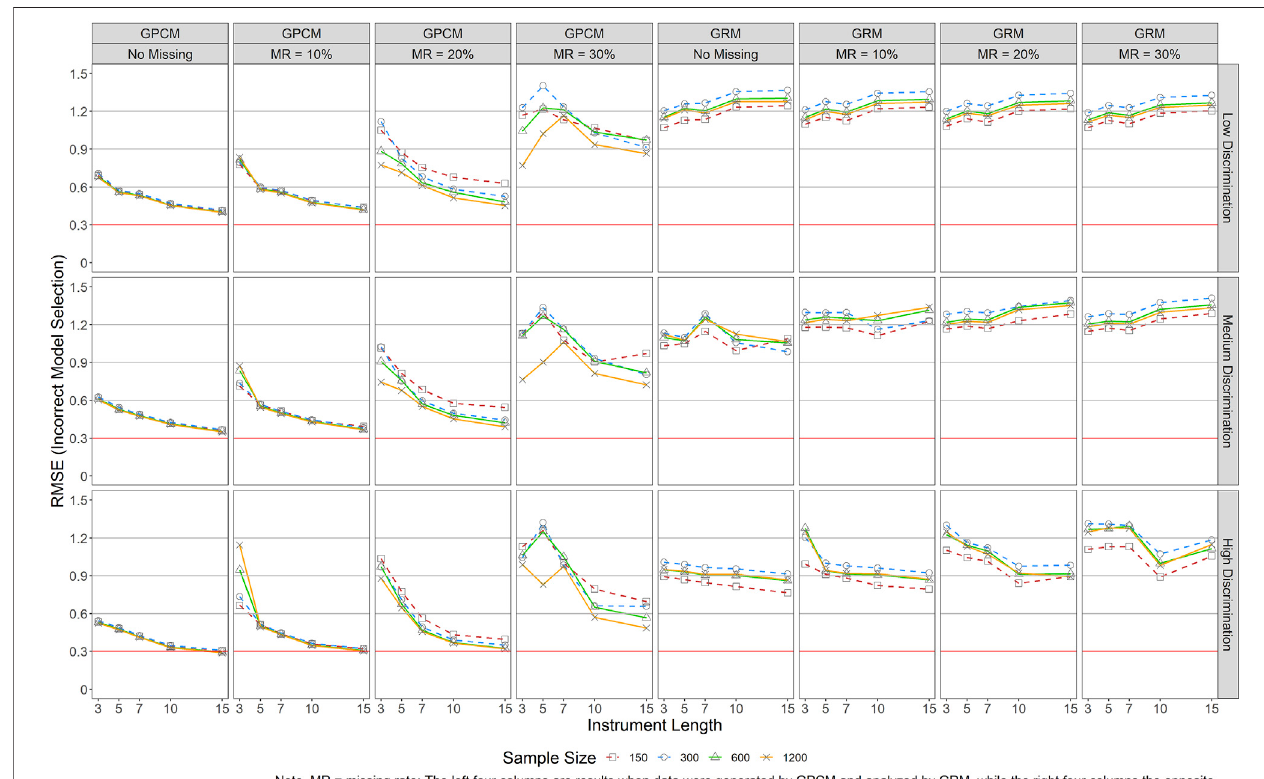
FIGURE 9 | RMSE Results of Person Parameter Estimations for Both GRM and GPCM (Incorrect Model Selection). Note. MR (cid:1) missing rate; The left four columns are results when date were generated by GPCM and analyzed by GRM, while the right four columns the